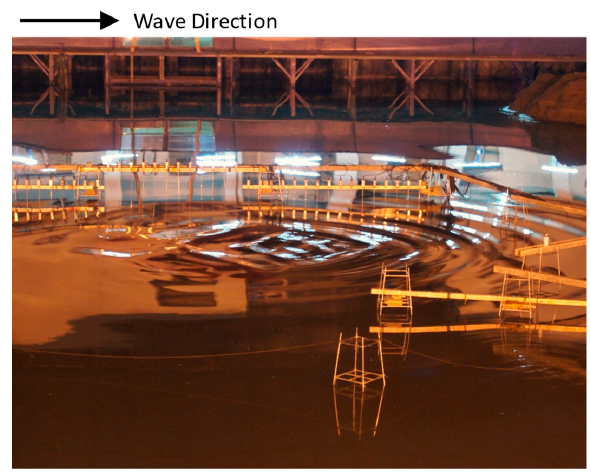
Figure 4. Observed wave-focusing phenomenon for wave condition of σ 2 h / g = 1.288 at normal incidence.